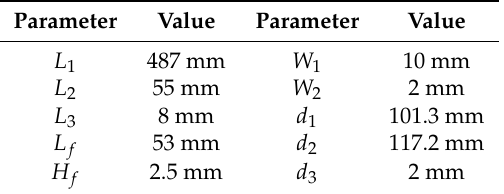
Table 1. Optimized dimensional parameters of the proposed